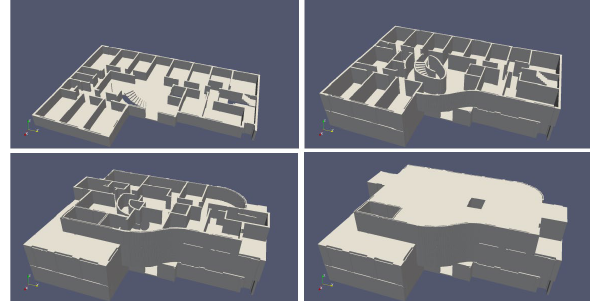
Figure 4. Sample three-storey building “Arboretum Professional Centre” at Seattle, WA (USA)